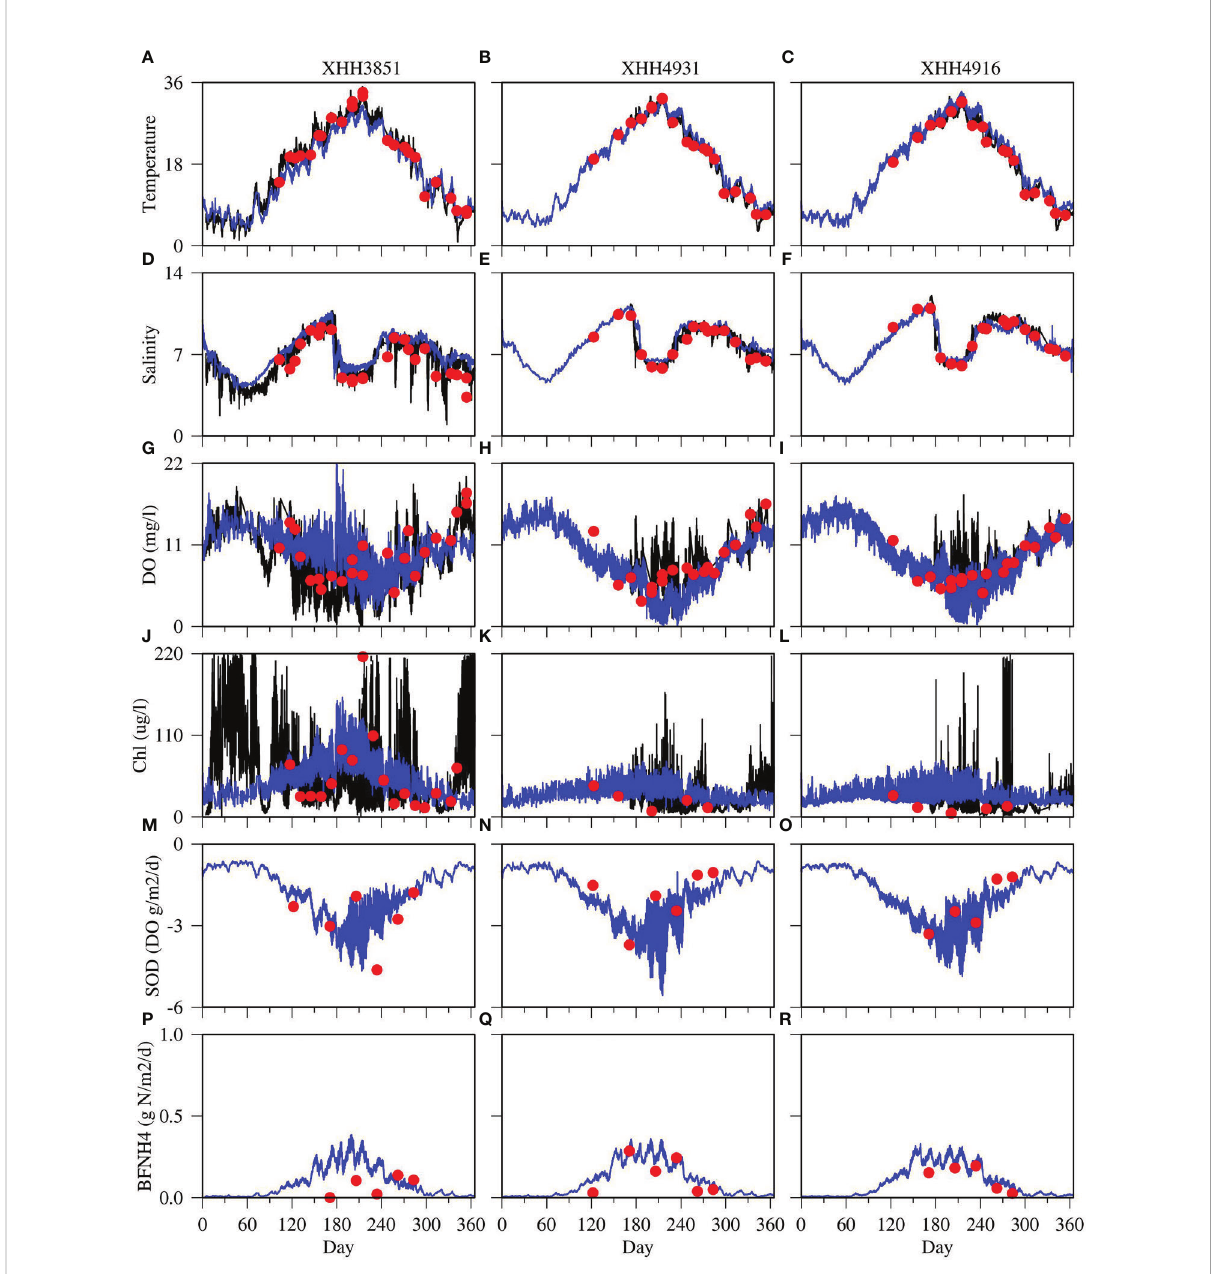
FIGURE 4 Comparison between model simulations (blue lines) with sensor-based continuous monitoring data (black lines) and cruise-based, discrete samples (red dots) at three observation stations. Each column displays an observation station with XHH3851 on the left, XHH4931 in the middle and XHH4916 on the right. Each row displays a variable with temperature on the top (A – C) , followed by salinity (D – F) , DO (G – I) , chlorophyll (Chl; J – L ), sediment oxygen demand (SOD; M-O ) and sediment ammonium fl ux (BFNH4; P – R